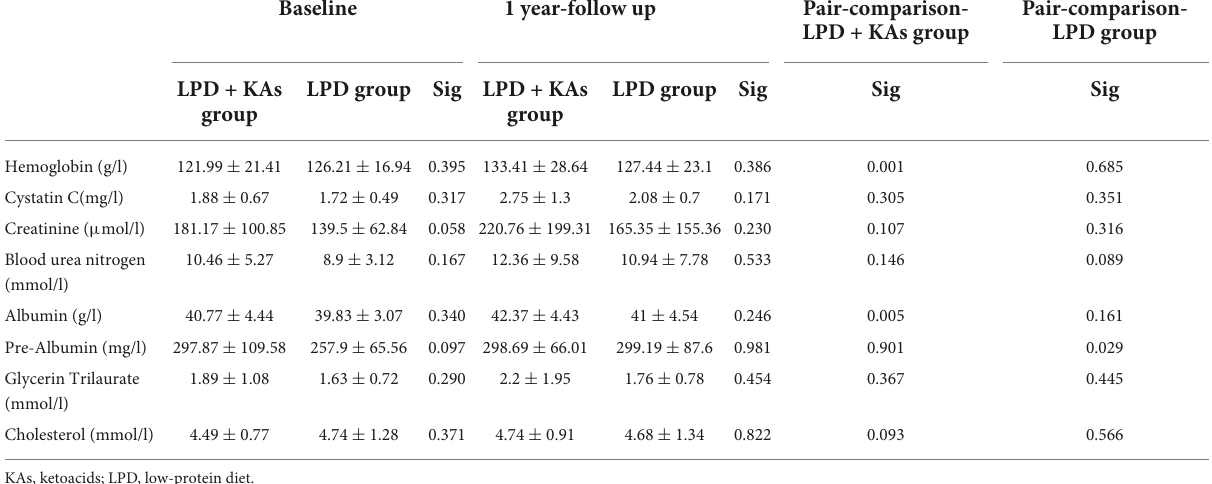
TABLE 2 Biochemical data of study participants at baseline and at the end of follow-up. Baseline 1 year-follow up Pair-comparison-